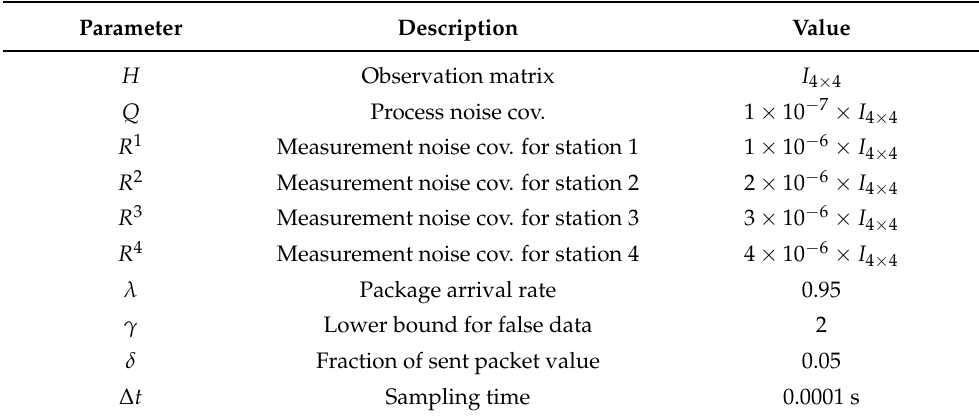
Table 1. Table of the parameters used for the simulations. Parameter